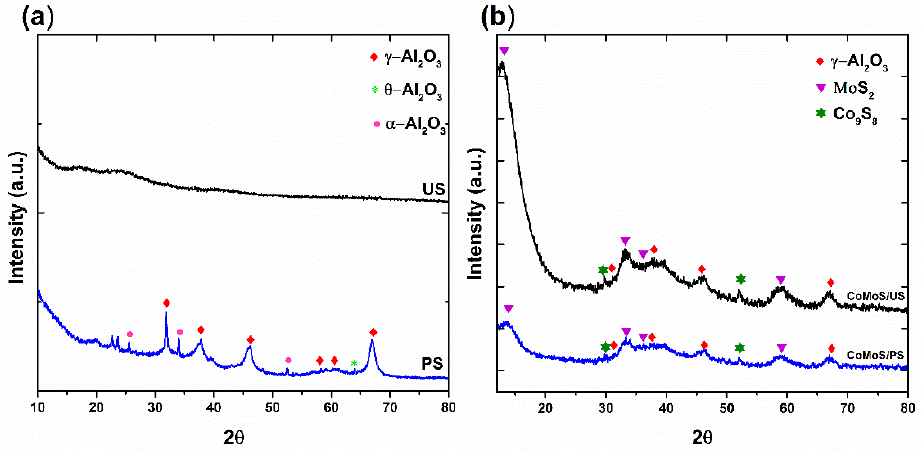
Figure 1. X-ray diffraction patterns of ( a ) US and PS supports; ( b ) CoMoS/PS and CoMoS/US